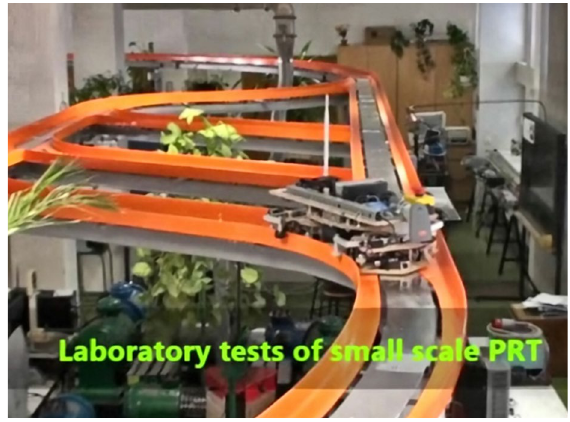
Fig. 1. Experimental track for studies of vehicle dynamics and motion control system operation